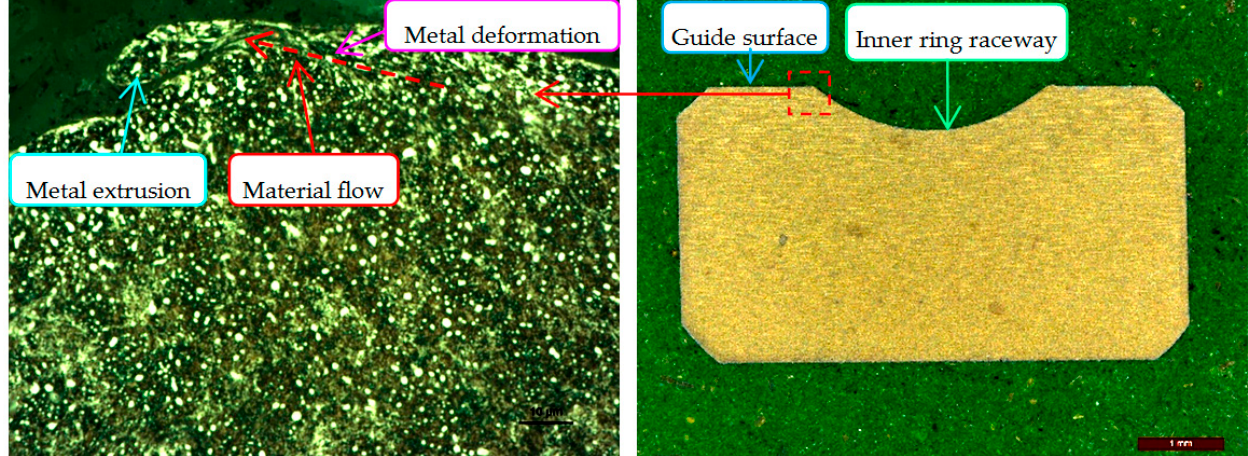
Figure 11. Microstructure, metal extrusion and deformation of the outer ring. Metallographic samples were respectively taken from the heavily or lightly damaged steel balls. The microstructure of the steel balls is normal, characterized by tempered martensite and spherical (Fe,Cr) 3 C carbide, and there are many cracks on the surface layer of the severely damaged steel balls, as shown in Figure 12.